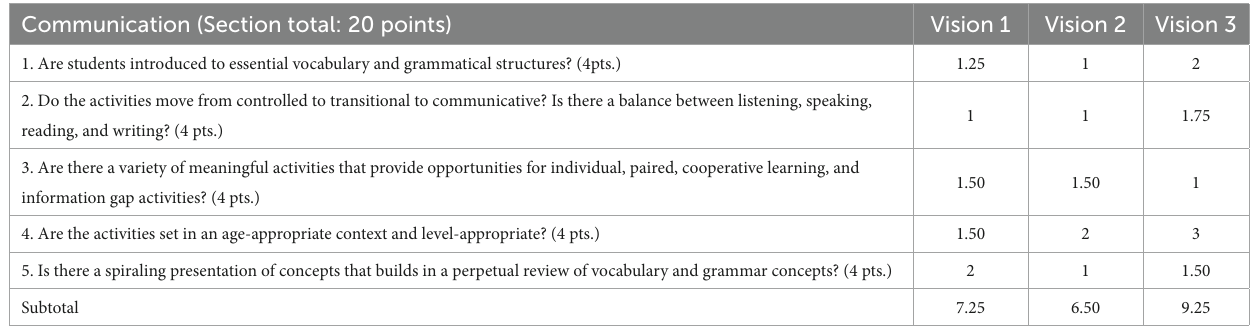
TABLE 1 Evaluation of Vision Series textbooks based on communication. Communication (Section total: 20